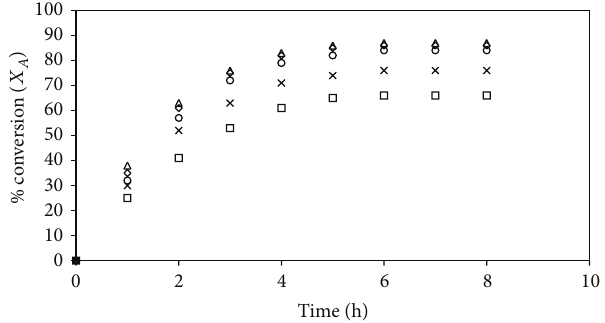
Figure 5: Effect of change in ratio of initial reactants on con- version of propionic acid ( 𝑇 = 80 ∘ C; 𝐶 𝐶 = 0.358 kmol/m 3 ; 𝑆/𝑉 = 15.19 m 2 /m 3 ): 𝑅 = 1 ( ◻ ), 𝑅 = 1.2 ( × ), 𝑅 = 1.3 ( l ), 𝑅 = 1.4 ( ♢ ), 𝑅 = 1.5 ( 󳵻